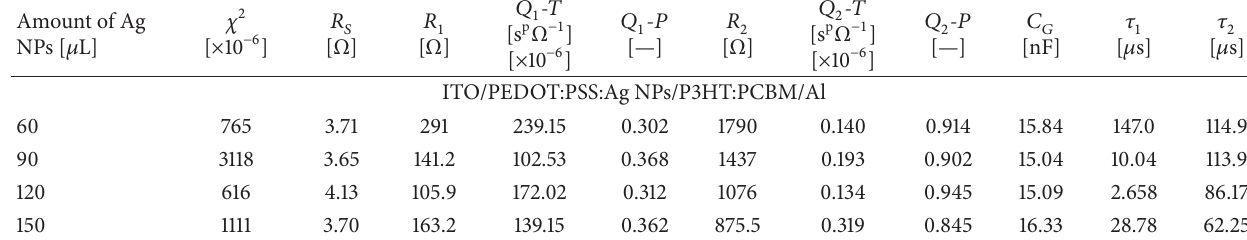
Table 4: The equivalent circuit parameters for ITO/PEDOT:PSS:Ag NPs/P3HT:PCBM/Al obtained from the fitting along with the mean relaxation times received from the parameters of fitting under illumination (halogen lamp).